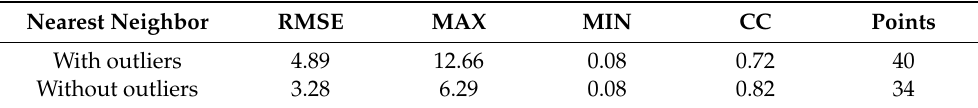
Table 3. The comparison summary of an average subsidence rate between PS results and leveling (unit: mm/yr).